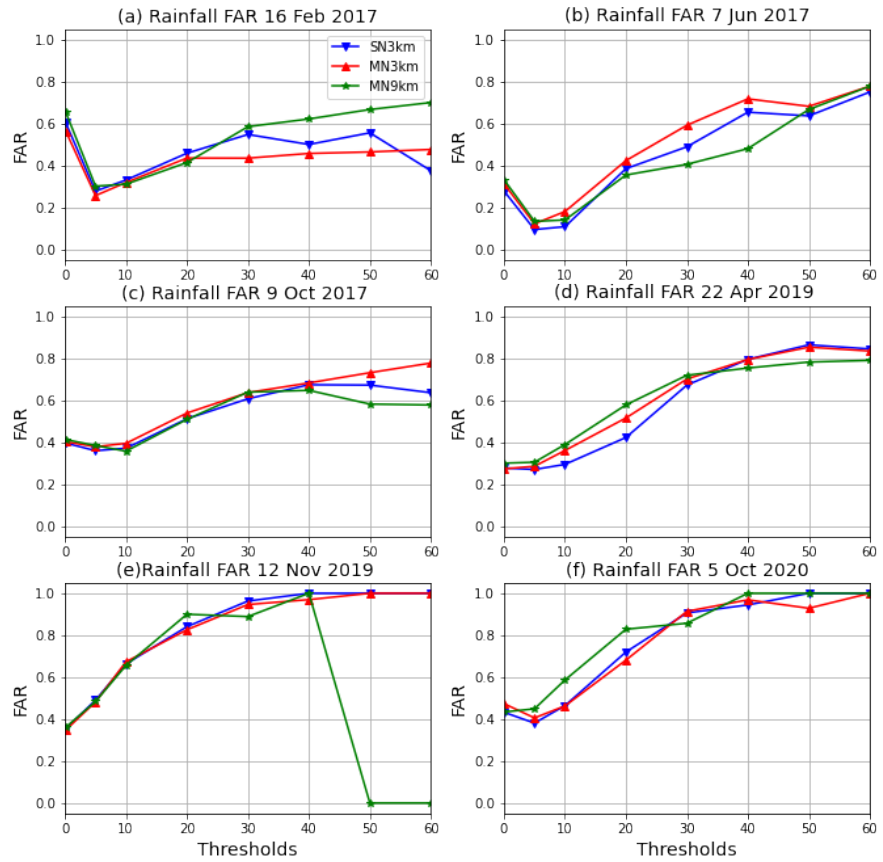
Figure 11. The False Alarm Rate for the three configurations and for all six events in the following order: ( a ) tropical cyclone Dineo, ( b ) the Cape storm, ( c ) the KZN 2017 October floods, ( d ) the KZN 2019 April floods, ( e ) the KZN 2019 tornadoes and ( f ) the Johannesburg